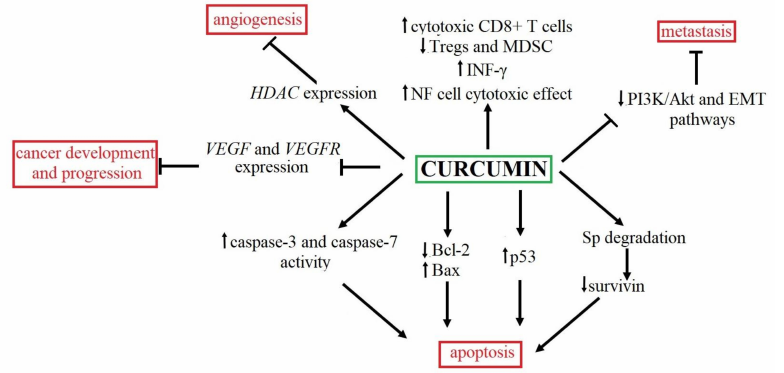
Figure 1. The summary of anticancer effects and mechanisms of curcumin action. Curcumin may modulate numerous signaling pathways, including angiogenesis [16], immune response [25–27], cancer development and progression [15,21–23] as well as apoptosis